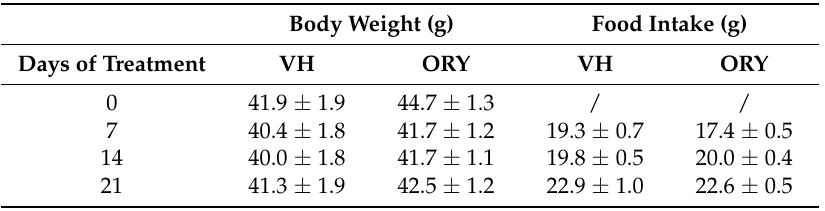
Table 2. Body weight and food intake. VH: vehicle; ORY: γ